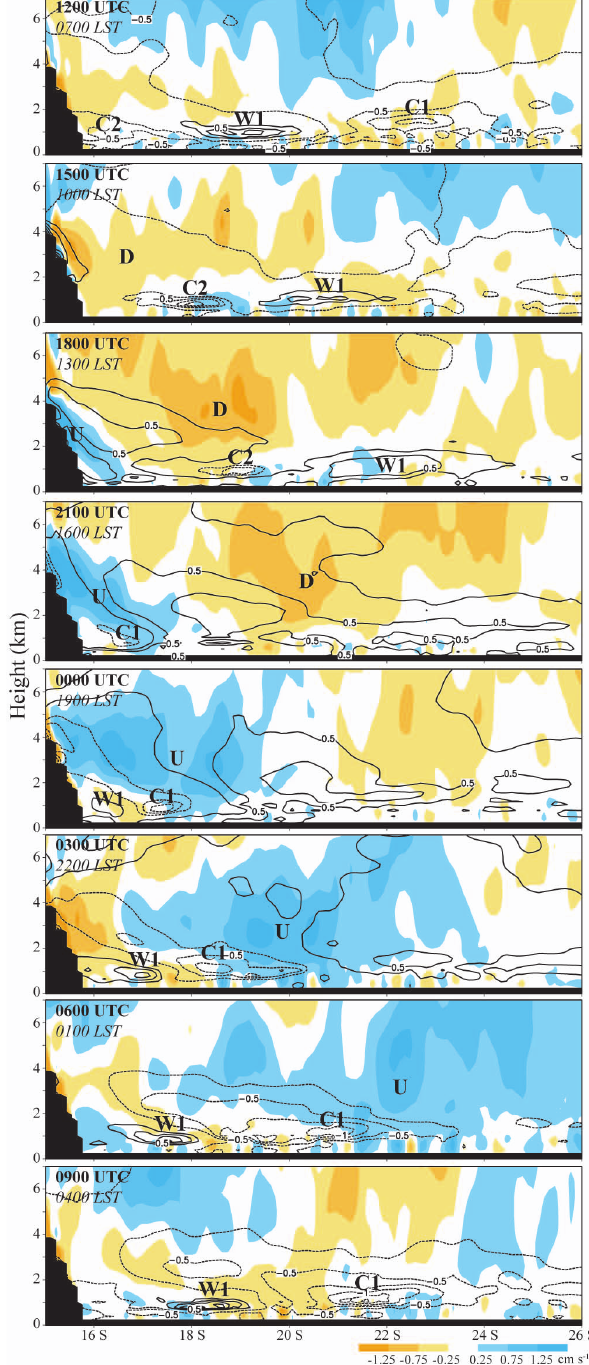
Fig. 10. WRF-simulated 2-month mean of hourly potential temper- ature anomalies (contours, K) and vertical velocity anomalies (color fill; cms − 1 ). The anomalies are shown in a cross-section extending southwest from Peru as depicted by the dashed line in the upper left plot of Fig. 7. Letters indicate (C1) the leading colder, deeper MBL anomaly, (W1) the warmer, shallower MBL, and (C2) the weaker trailing colder, deeper MBL. Letters indicate regions of (U) upward and (D) downward motion.